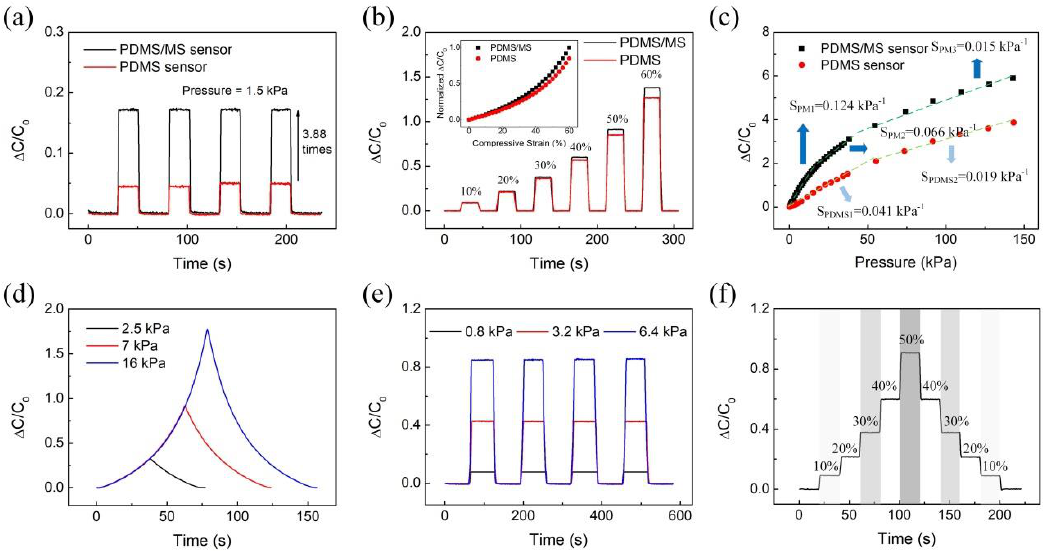
Figure 5. The measured sensing performance of the capacitive pressure sensor based on the PDMS/MS composite. ( a ) Comparison of measurement capacitance variation with loading and unloading with time. ( b ) The capacitance values of PDMS/MS and PDMS sensor with different strain (10~60%). Inset graph shows the analytical calculations. The experimental and analytical calculations show good agreement. ( c ) Pressure-response curves for sensors based on the PDMS/MS composite and bare PDMS structure. ( d ) Variation of capacitance of the PDMS/MS composite with same strain rate (10% strain min − 1 ) under different applied stress. ( e ) Reproducibility test of sponge under different applied stress with time. ( f ) The measured hysteresis error in consequent loading and unloading steps.